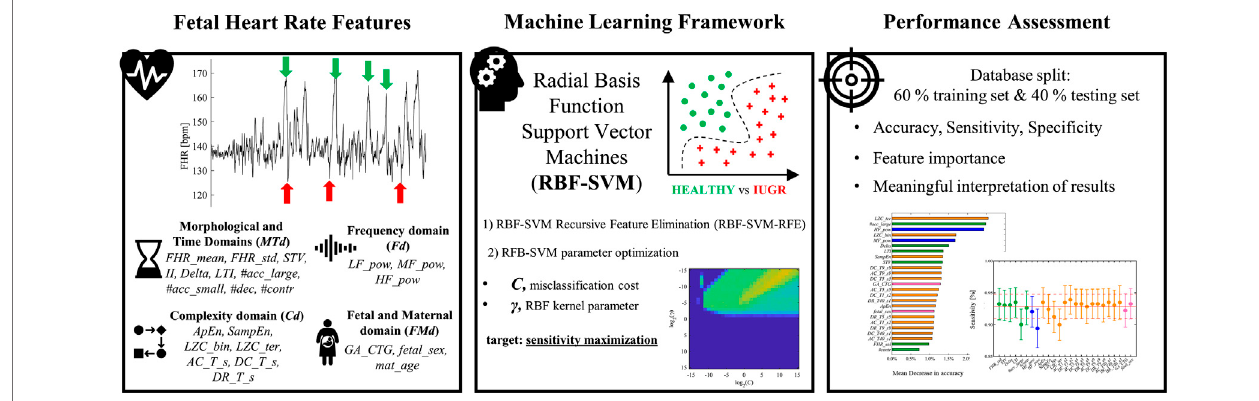
FIGURE 1 | A schematic depiction of the machine learning framework to monitor the emergence of late intrauterine growth restriction. The starting point was the extraction of fetal heart rate physiology features. Morphological and Time Domains (MTd) – mean, standard deviation of entire FHR signal (FHR_mean, FHR_std) ; Short Term Variability (STV) ; Interval Index (II) ; Delta; Long Term Irregularity (LTI) ; large accelerations (more than 15 beats per minute over the baseline lasting 15 s or more, indicated by green arrows) (#acc_large) ; small accelerations (fewer than 15 beats per minute) (#acc_small) ; decelerations ( #dec, indicated by red arrows); contractions (#contr) . Frequency domain (Fd) – power in the low frequency (LF) band (LF_pow) ; power in the movement frequency (MF) band (MF_pow) ; power in the high frequency (HF) band (HF_pow) . Complexity domain (Cd) — Approximate Entropy (ApEn) ; Sample Entropy (SampEn) ; binary, ternary Lempel Ziv Complexity (LZC_bin, LZC_ter) ; Average Acceleration, Deceleration Capacities (AC_T_s, DC_T_s) ; Deceleration Reserve (DR_T_s) . Fetal and Maternal domain (FMd) – GA at the recording (GA_CTG) ; fetal sex (fetal_sex) ; maternal age (mat_age) . Radial basis function support vector machine (RBF-SVM) model was developed to discriminate between healthy and late IUGR fetuses. The ensemble of previously described features was reduced by means of Recursive Feature Elimination technique (RBF-SVM- RFE). The optimization of RBF-SVM parameters C and c aimed at maximizing sensitivity is shown in the bottom graph of the Machine Learning Framework panel. Performance was assessed by splitting the database of 160 healthy and 102 late IUGR fetuses in a training (60%) and independent testing set (40%). Several fi gures of merit were computed. Additionally, the proposed implementation of RBF-SVM allowed deriving interpretable feature importance ranking and standalone feature contribution to accuracy, sensitivity, and speci fi city (left and right (only sensitivity shown) graphs in the Performance Assessment panel).